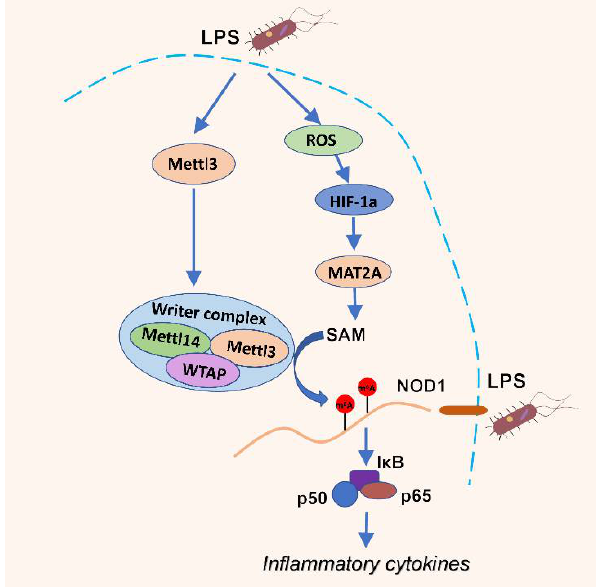
Figure 7. The proposed mechanism for the regulation of m 6 A RNA methylation in the NOD1/ NF- κB signaling activation in the liver of piglets challenged with LPS.